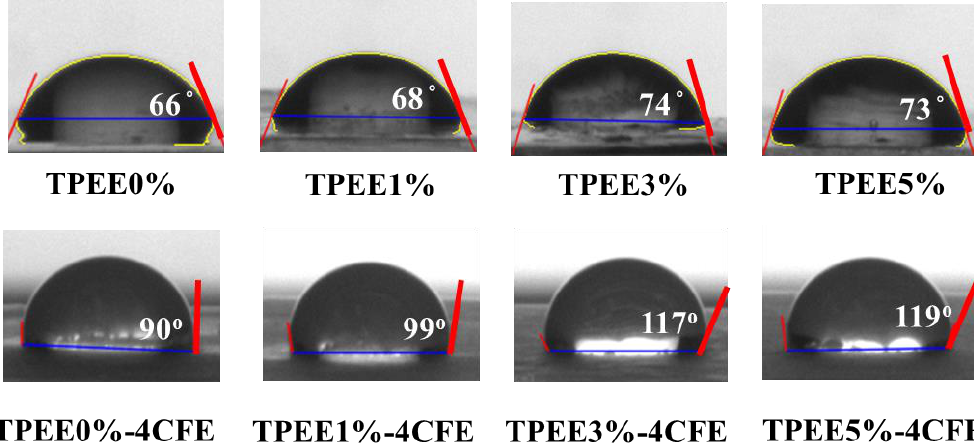
Figure 7. The contact angle results for the TPEEn% and TPEEn%-4CFE membranes.